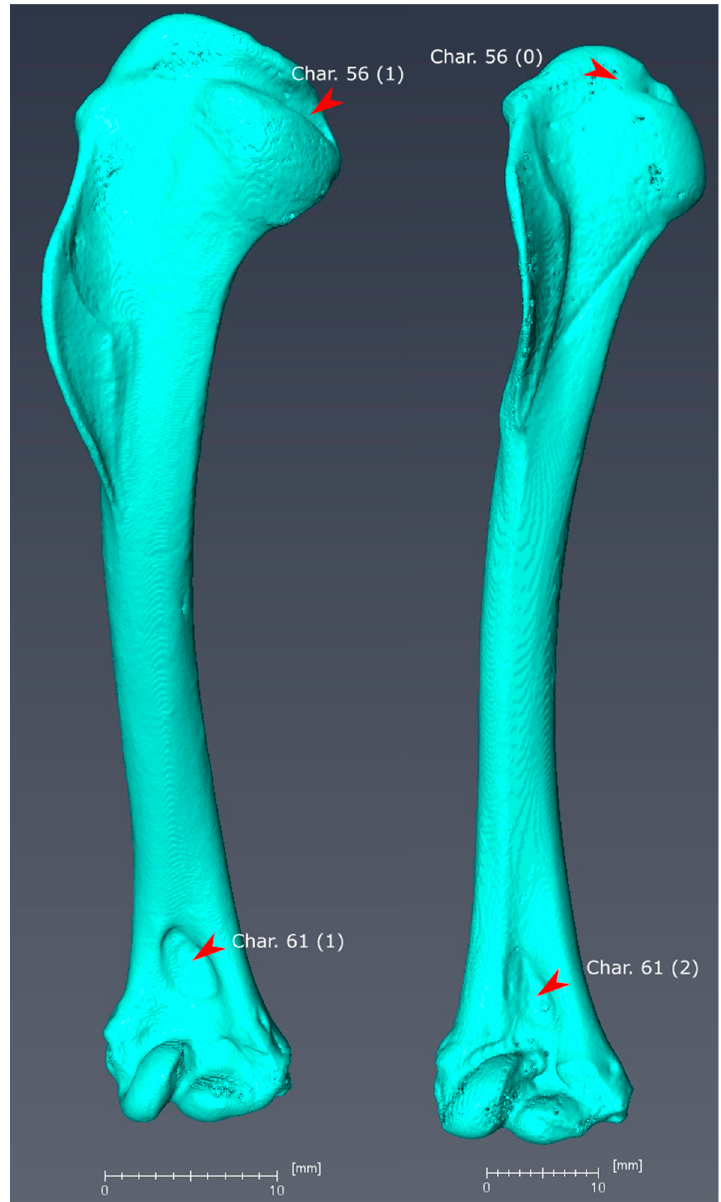
Figure A1. Humeri of Nyctibius griseus (left) and Podargus strigoides (right) in cranial view. Nyctibius exhibits state 1 for character 56 (transverse sulcus on humerus very deep, long, and rectangular, optimized as a synapomorphy of Strisores), whereas Podargus exhibits state 0 (transverse sulcus on humerus not deep, long, and rectangular, optimized as a synapomorphy of Podargiformes). Nyctibius also exhibits state 1 for character 61 (shallow fossa m. brachialis on humerus), whereas Podargus exhibits state 2 (deep fossa m. brachialis on humerus, optimized as a synapomorphy for Podargiformes as well as Steatornithiformes). Note that even though Podargus has a fossa m. brachialis of greater depth, the rim of the fossa is of steeper relief in Nyctibius